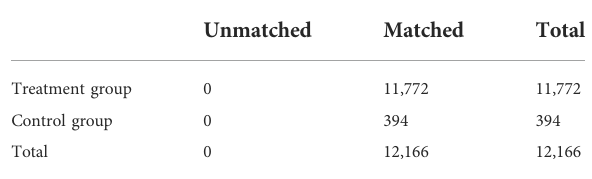
TABLE 2 The PSM